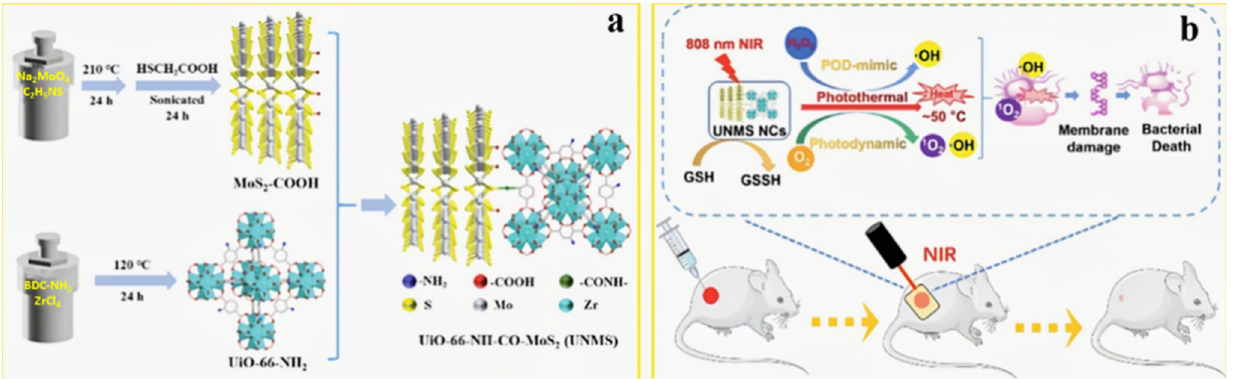
Figure 32. Diagram of ( a ) preparation process of UNMS NCs; ( b ) the actericidal mechanism of UNMS NCs and treatment of wound infection (reproduced with permission of John Wiley & Sons, Inc. from ref. [115]).